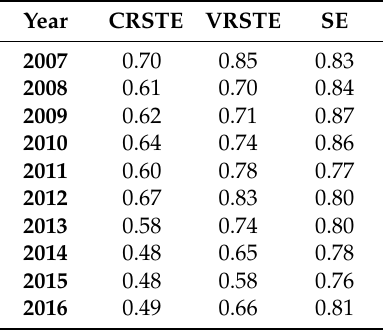
Table 4. The average of comprehensive efficiency (CRSTE), pure technical efficiency (VRSTE), and scale efficiency (SE) of the environmental management in the Yangtze River urban agglomeration from 2007 to